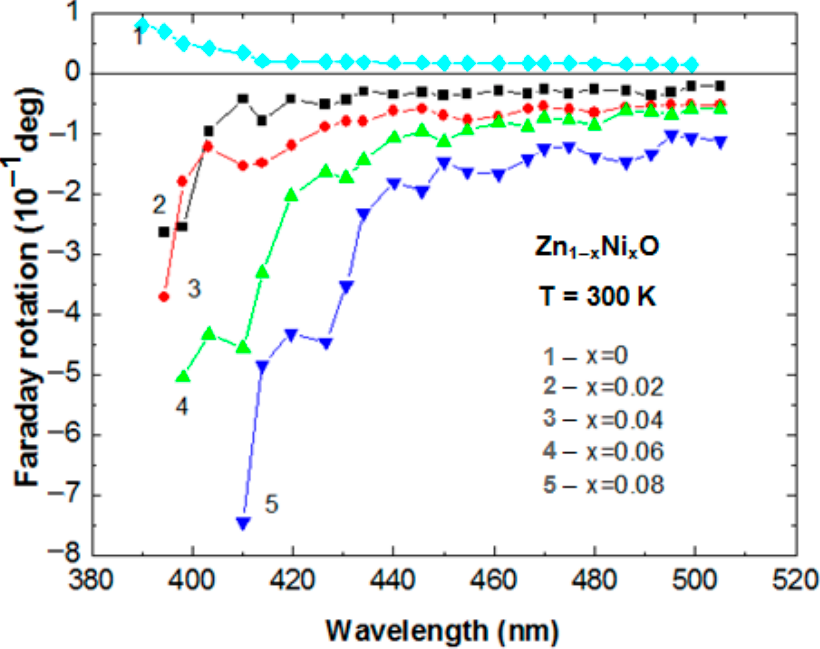
Figure 8. PL spectra of Ni-doped ZnO thin films with different Ni content.